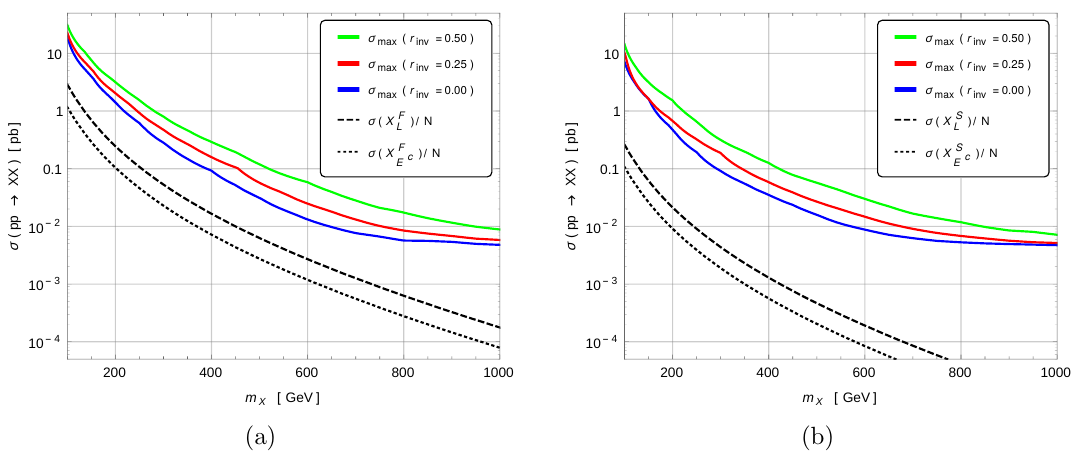
Figure 5. Upper limits at 95% CLs on the cross section for (a) fermion mediators and (b) scalar mediators of category II from the LHC leptoquark search of ref. [50] and r inv ! 0. Assuming G to be SU( N ), the di(cid:11)erent cross sections divided by N are also presented. that minimizes the invariant mass di(cid:11)erence and taking the smallest invariant mass of the two. A set of 27 overlapping signal regions are then de(cid:12)ned in terms of these variables, each signal region being optimized for a di(cid:11)erent leptoquark mass. We exclude a point if any individual signal region contains more signals than its 95% CLs upper limit. We veri(cid:12)ed that we could reproduce their leptoquark results with good accuracy. A number of 20000 events were generated. The main backgrounds